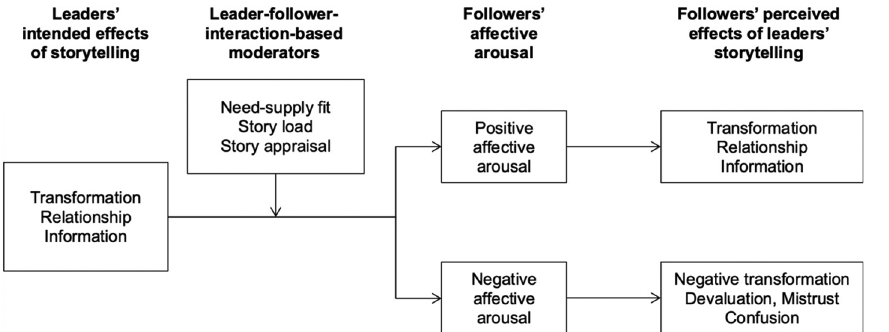
Figure 2. Intention-perception model of